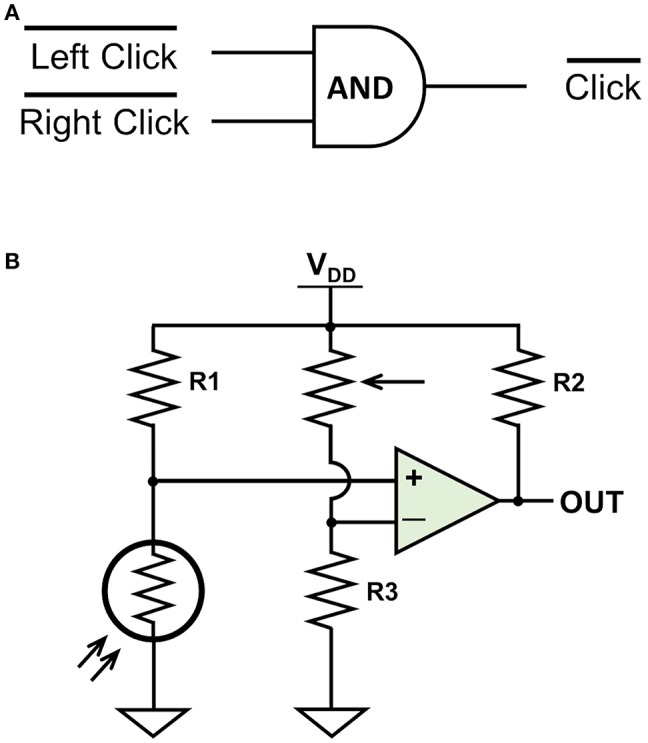
The primary circuits designed for auxiliary digital triggers. (A) The mouse circuit. (B) The photoresistor circuit. The mouse circuit sends a 1 when neither mouse button is clicked. When either the left click or right click is triggered, the corresponding side is connected to ground and a 0 is sent to the aux port. The photoresistor circuit sends a 1 when the photoresistor senses no light. The potentiometer and R3 form a resistive voltage divider to create an adjustable reference voltage that is fed into the negative side of the comparator. When the photoresistor detects light during stimulus onset, the voltage on the positive side of the comparator is higher than the reference voltage and a 0 is sent to the aux port.